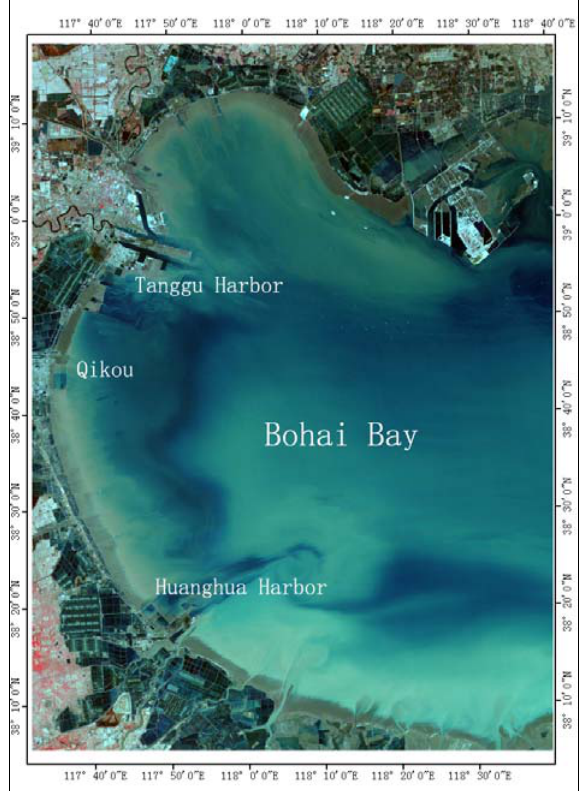
Figure.1 the study area (BJ-1